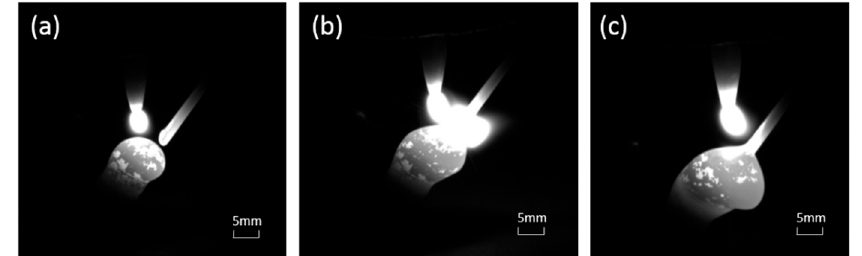
Figure 7 . Four typical rods with different preset layer height; ( a ) the typical sample morphology with 0.45 mm preset layer height; ( b ) the typical sample morphology with 0.5 mm preset layer height; ( c ) the typical sample morphology with 0.55 mm preset layer height; ( d ) the typical sample morphology with 0.55 mm preset layer height in the first five layers, which then becomes 0.5 mm.